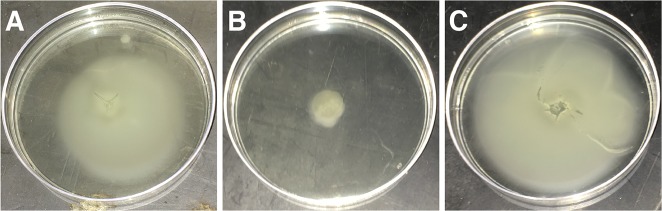
Semi-solid (0.15% agar) assay confirming motility of wild type OCN003 cells (A), the lack of motility of the OCN003 ΔfliF::bla mutant cells (B), and the restored motility of the complemented OCN003 ΔfliF::bla mutant cells (C).